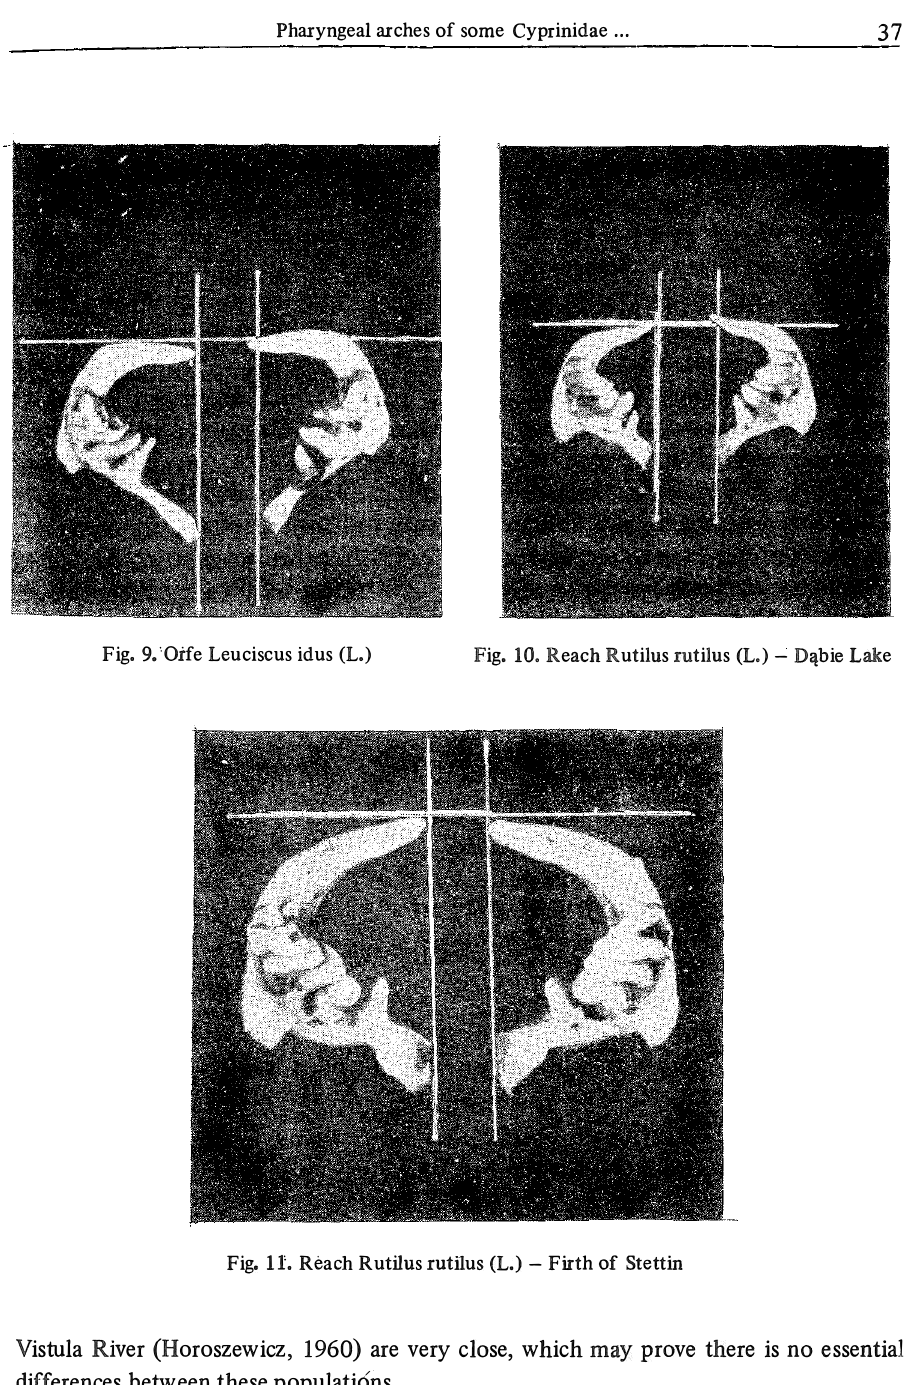
Fig. 11. Reach Rutilus rutilus (L.) -Firth of